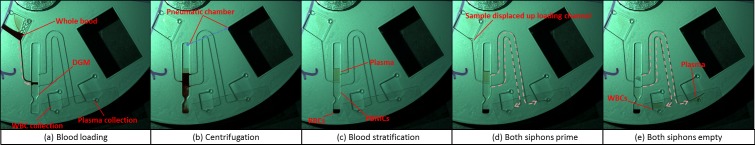
WBC isolation using a dynamically CPSV (Disc D).(a) The disc loaded with DGM while the whole blood is introduced during disc acceleration. (b) RBCs sediment to the bottom. Note that the pneumatic chamber is extended by channel (lower level) indicated in a blue dash. This large pneumatic chamber is required to ensure that the valves function at the volumes processed. (c) Stratified blood in the chamber. (d) The spin rate is decreased and both siphons are simultaneously primed. Note that the siphon crests are located radially inwards of the bulk liquid and the liquid displaced radially inwards along the loading channel. (e) The spin rate is increased and both siphons empty. See ESI S1 Movie showing blood processing in Disc D.